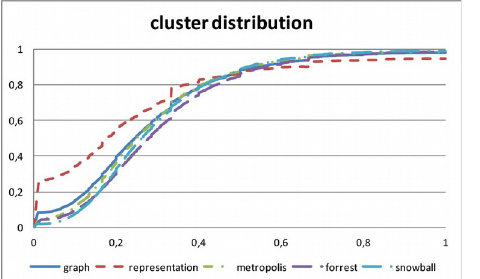
Figure 1. Degree, path length and cluster